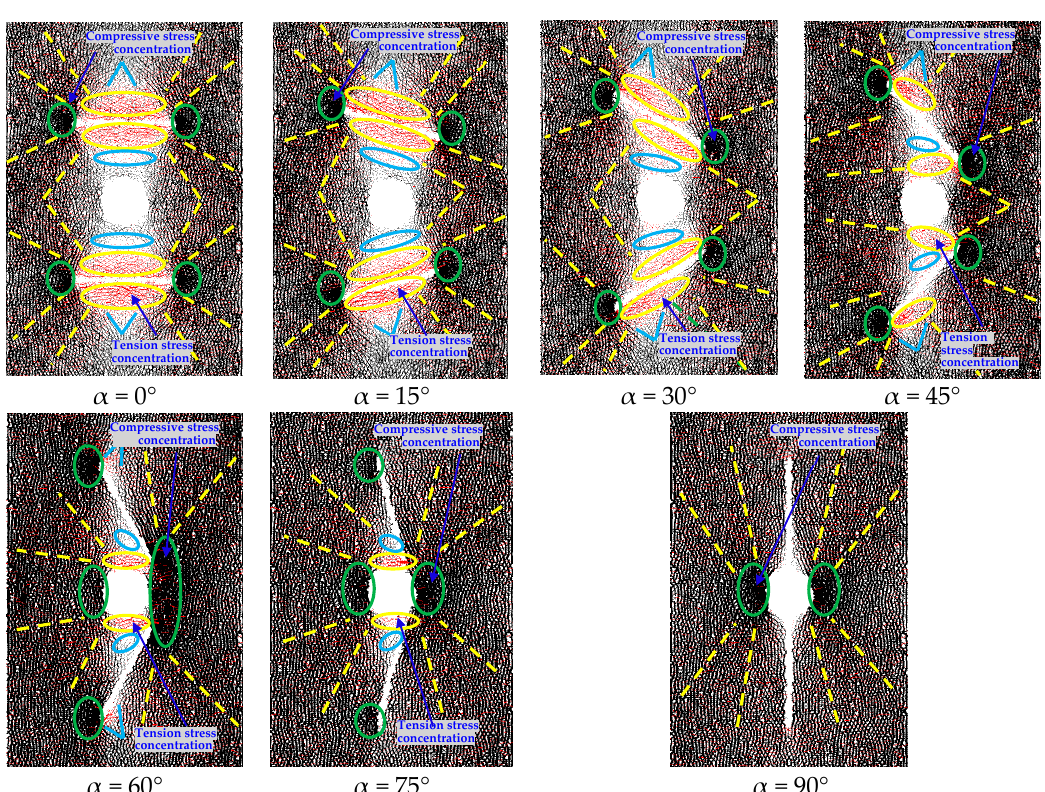
Energies 2021 , 14 , x FOR PEER REVIEW Figure 9. The distributions of contact force chains before microcrack initiation in the crack-circle composite model.